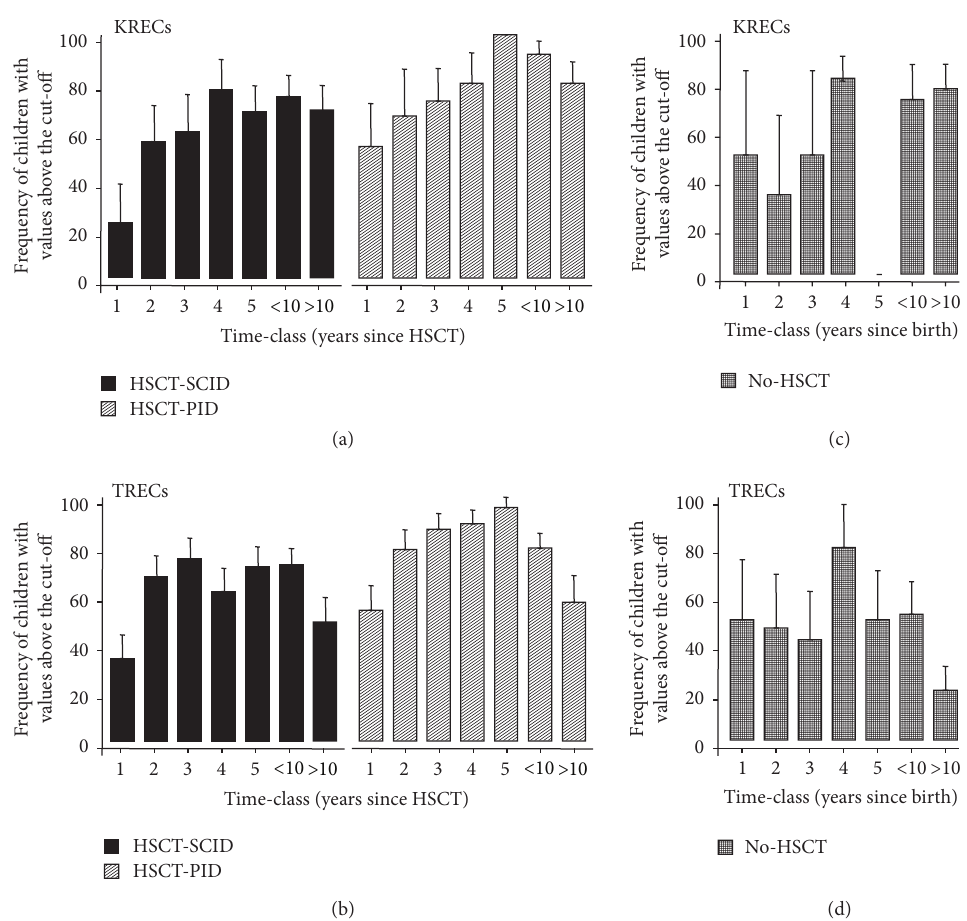
Figure 1: ((a) and (b)) Average frequency of children with SCID and PID receiving HSCT (HSCT-SCID and HSCT-PID, resp.) with values of KRECs and TRECs over the respective cut-offs, calculated in age-matched healthy children. ((c) and (d)) Average frequency of children with SCID and PID that were not subjects to HSCT (no-HSCT), with values of KRECs and TRECs over the cut-offs. The indicated time-classes for HSCT children were calculated starting from the date of HSCT, whereas in no-HSCT children each time-class represents the age at the time of sampling. Time-classes were indicated as follows: 1: < 1 year, 2: < 2 years, 3: < 3 years, 4: < 4 years, 5: < 5 years, < 10: < 10 years, and > 10: > 10 years. Bars represent the means and error bars represent the standard